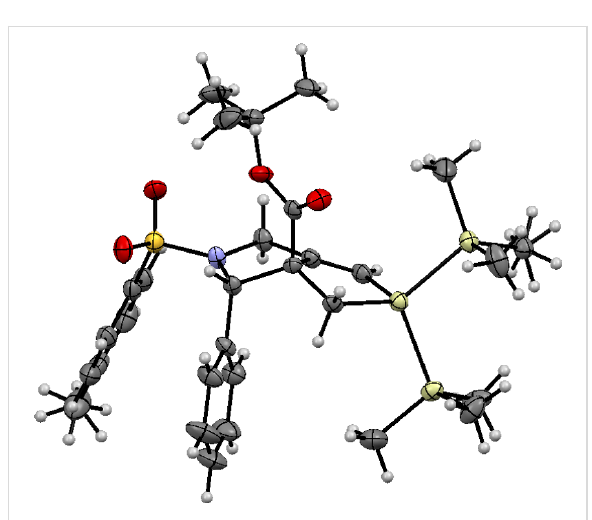
Figure 1: ORTEP structure of trans - 2a